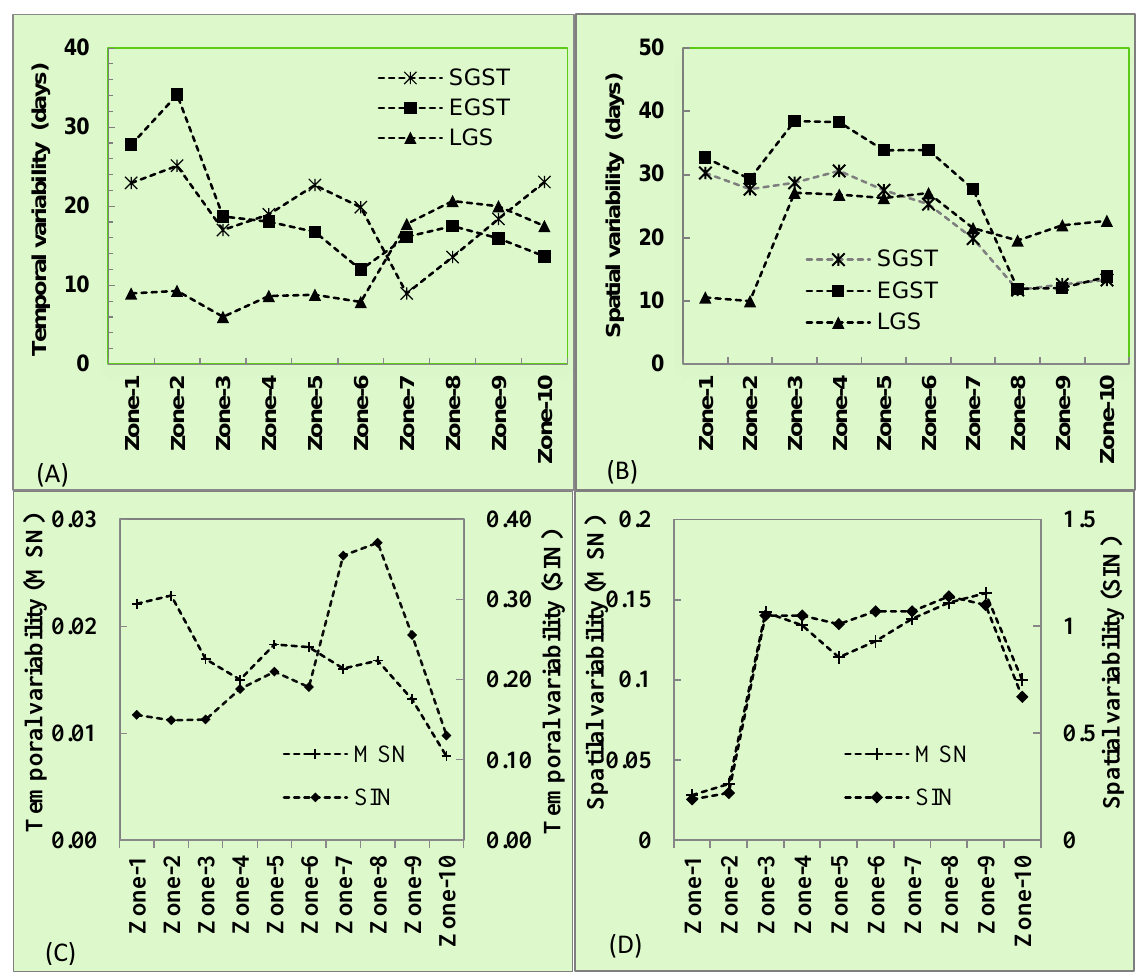
Figure 5. ( A , B ) Temporal and spatial variability of phenology calendar and ( C , D ) productivity patterns across the elevation zones. Temporal variability is the average temporal variance of the spatial mean of all pixels in each zone; spatial variability is the average spatial variance of the temporal mean of all pixels in each